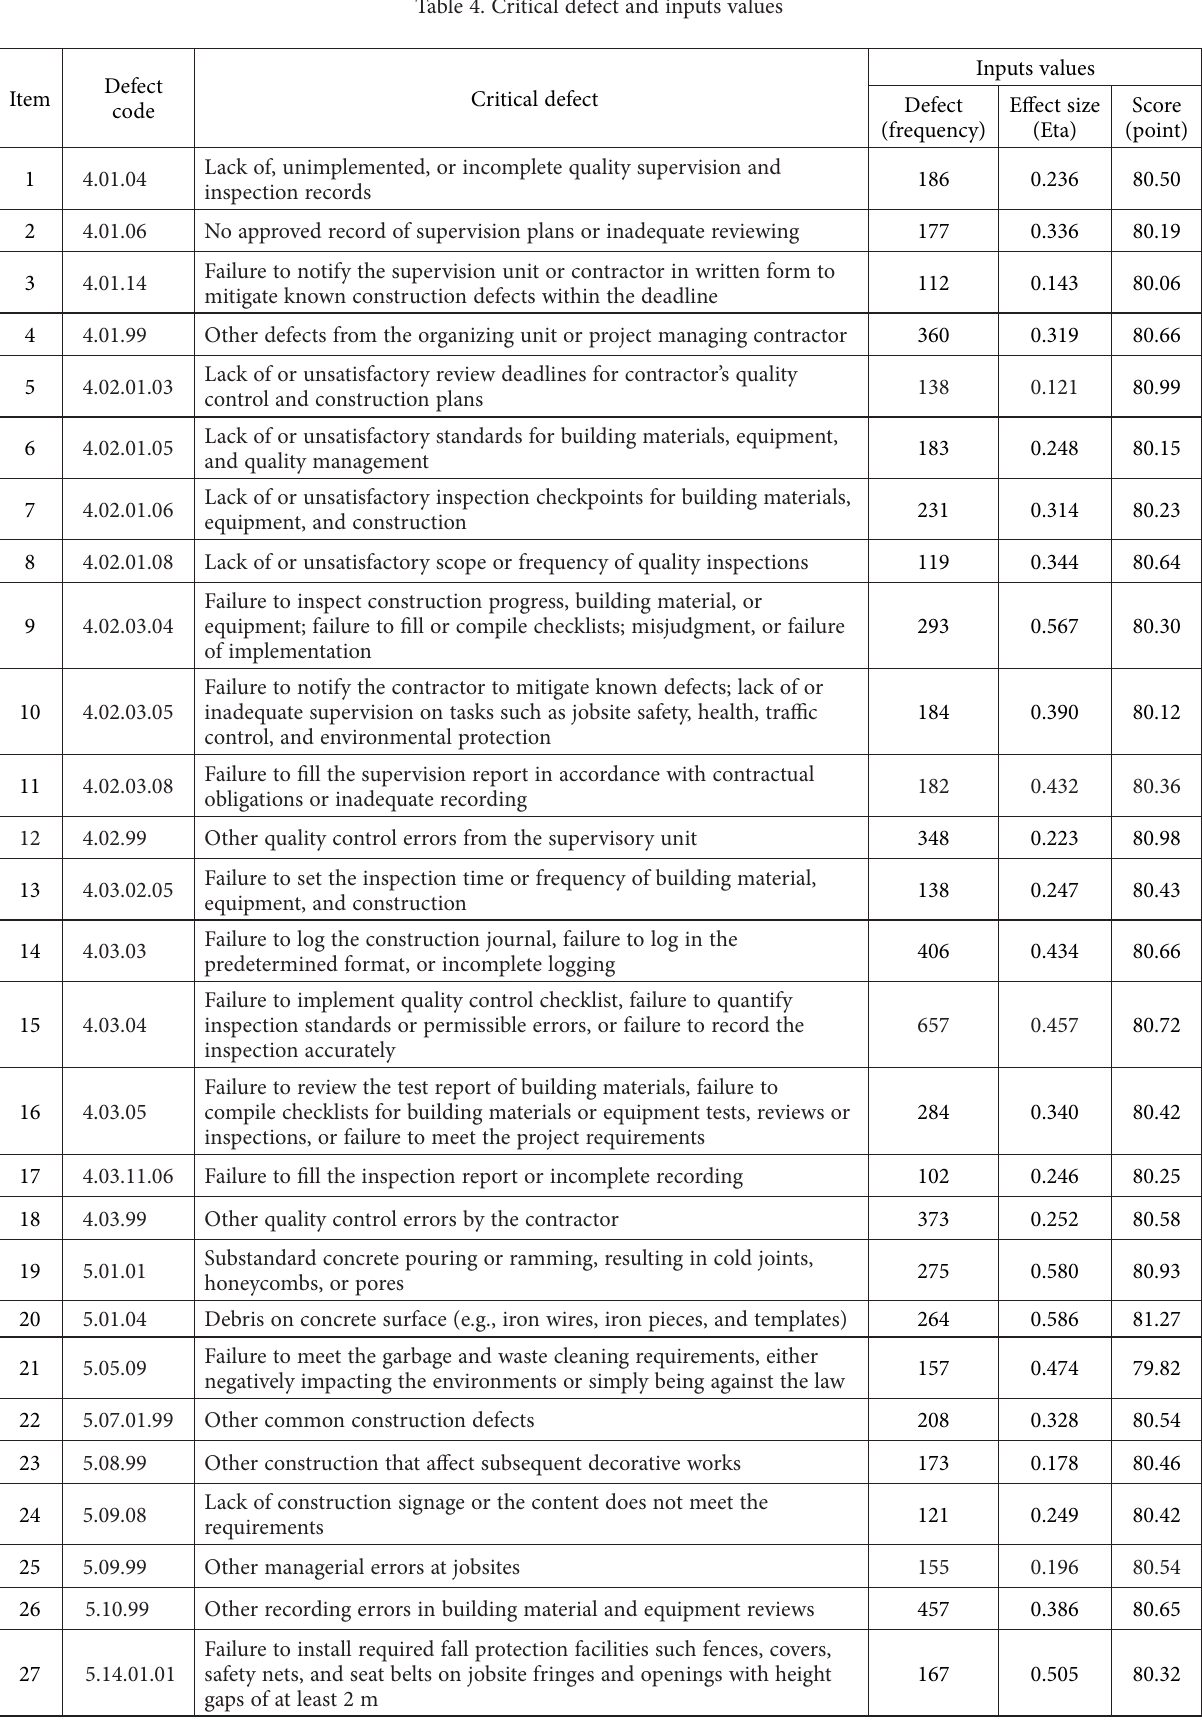
Table 4. Critical defect and inputs